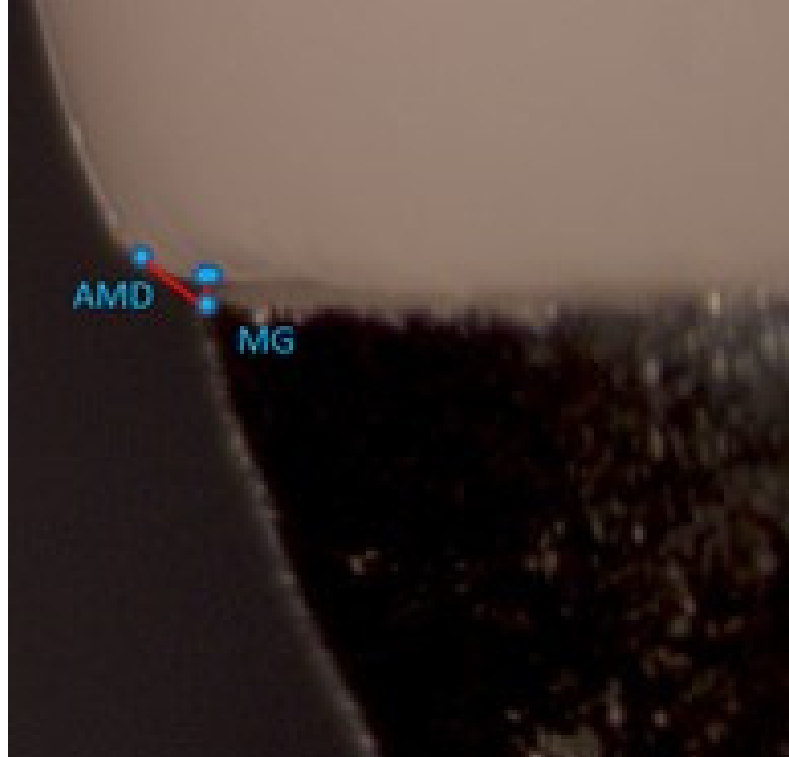
Figure 5. Representative image of the crown–abutment marginal junction showing MG and AMD measurements.